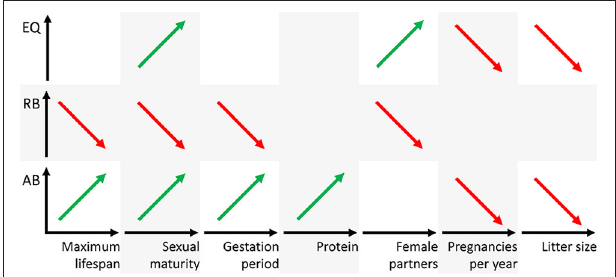
FIGURE 6 | Schematic representation of positive (green) or negative (red) correlations figuratively depicted as regression line of the three brain dimensions AB, RB, and EQ (ordinates) and the biological parameters (abscissas). Note that the parameters maximum lifespan, sexual maturity, and gestation period are time axes, the parameter protein is mass and the parameters female partners, pregnancies per year, and litter size are